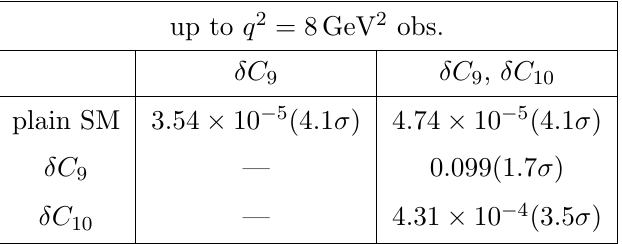
Table 7 . Likelihood ratio p -values and signi(cid:12)cances obtained using Wilks’ theorem for observables up to q 2 = 8 GeV 2 .